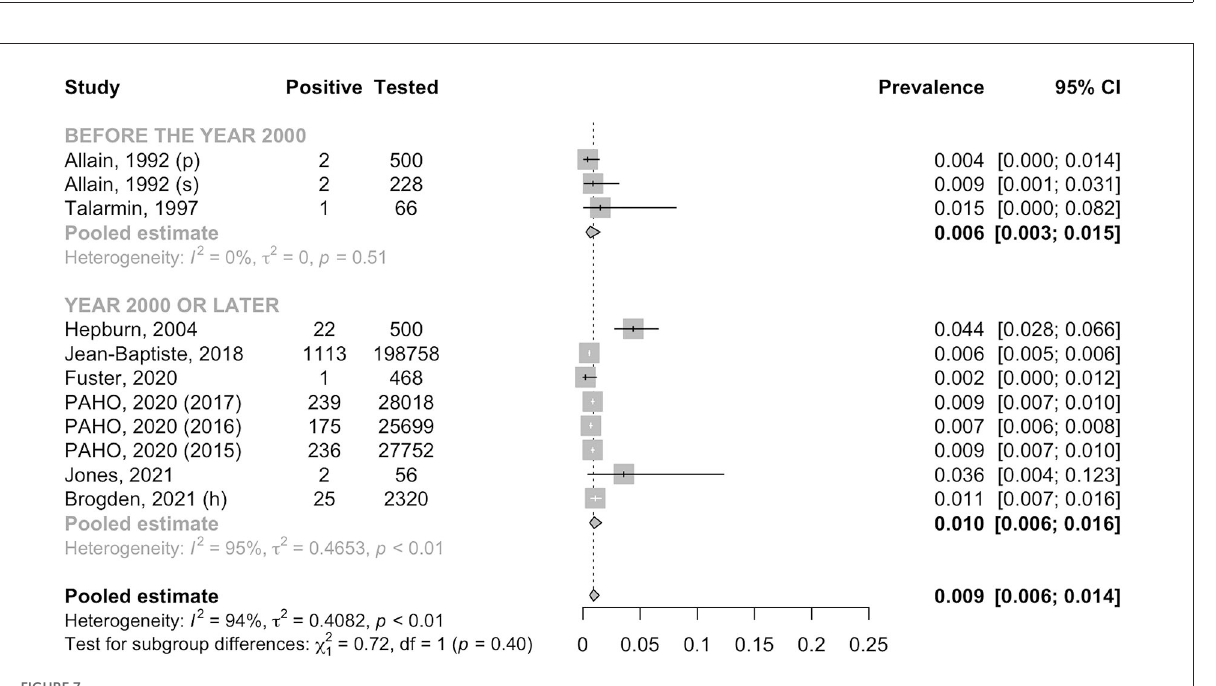
All but one study constantly showed that the prevalence of anti-HCV was below 1%, which is close to the average for the Americas (0.7%, 95% CI: 06–0.8). There was no significant